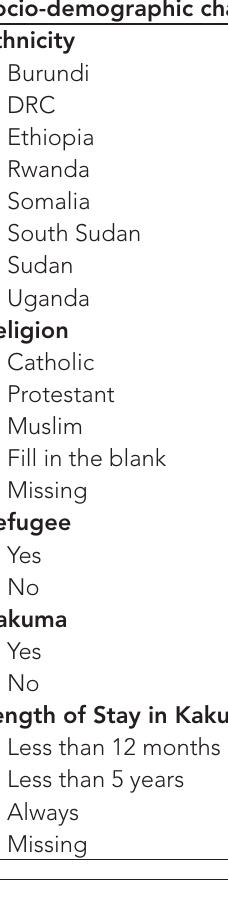
Table 2: Demographic Characteristics of Sample (Refugee camp) Socio-demographic